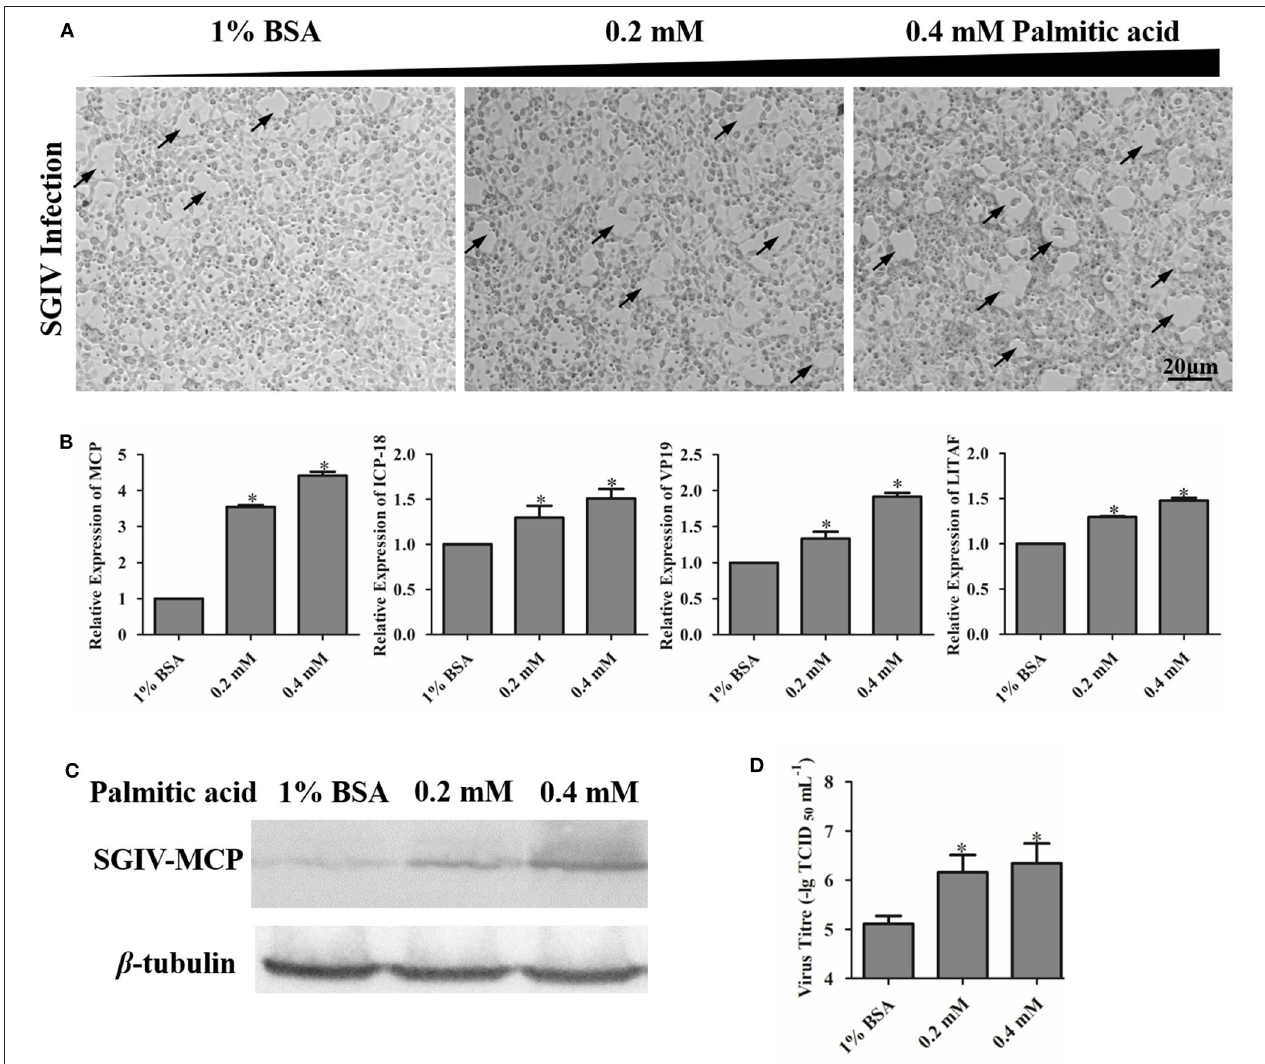
FIGURE 4 | Palmitic acid enhanced SGIV replication. (A) The severity of CPE induced by SGIV infection in palmitic acid incubated cells was observed under the microscope (Zeiss). The arrows show the CPE induced by SGIV infection. (B) The relative expressions of SGIV-MCP, SGIV-LITAF, SGIV-ICP-18, and SGIV-VP19 genes after SGIV infection were evaluated by qRT-PCR. The relative expression ratio of the selected gene vs. β - actin (reference gene) was calculated using the 2 − 11 CT method. (C) Virus protein level increased after palmitic acid treatment. The level of SGIV-MCP was detected by western blot, and β -tubulin was used as the internal control. (D) Virus production of SGIV was evaluated. GS cells incubated with indicated concentration palmitic acid (0, 0.2, or 0.4mM palmitic acid) were infected with SGIV and collected at 24h p.i. Viral titers were determined using the TCID 50 method. The data are represented as mean ± SD, and the statistical significances were determined with Student’s t -test, n = 3. The significance level was defined as * p <